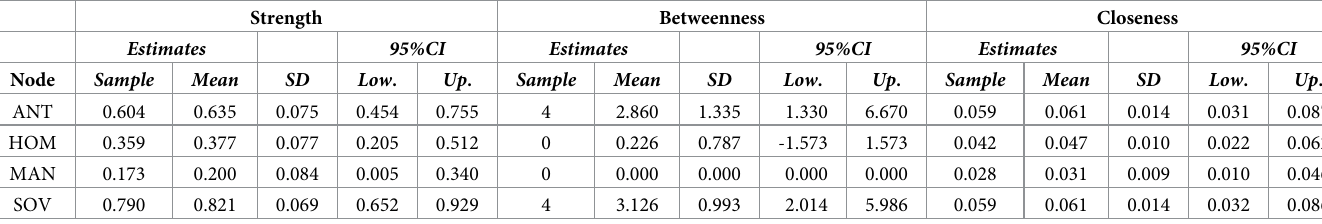
p < .001, η 2 = .40). As shown in Fig 7, averages closely conformed to Zulianello’s (2020) classi- fication. Bonferroni post-hoc comparisons indicated that Forza Italia’s voters (i.e., right-wing populist voters with a lower score of right-wing political orientation) showed a mean score that was significantly shifted to the right side of the continuum, compared to the populist counter- part of M5S voters ( M = 1.26, se = .19, p < .001, 95%CI = 0.635, 1.880). M5S voters showed diff intermediate value, placed exactly in the middle of the left–right spectrum, and—importantly —that was significantly to the right of Democratic Party voters (i.e., a classic social democrat